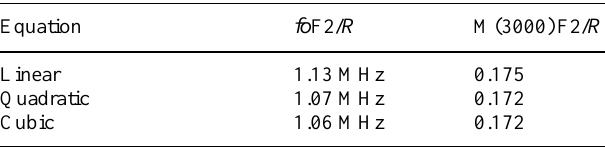
Table 5. Overall standard errors of estimate given by daily analyses when different polynomial orders are adopted